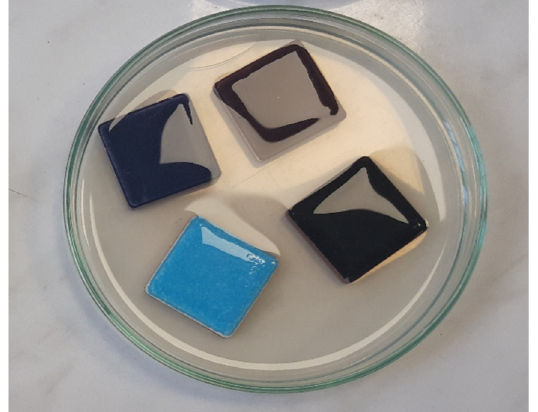
Figure 1. Sterile ceramic tiles placed in a Petri dish, immersed in agar, and covered with suspension of test P. aeruginosa bacteria.